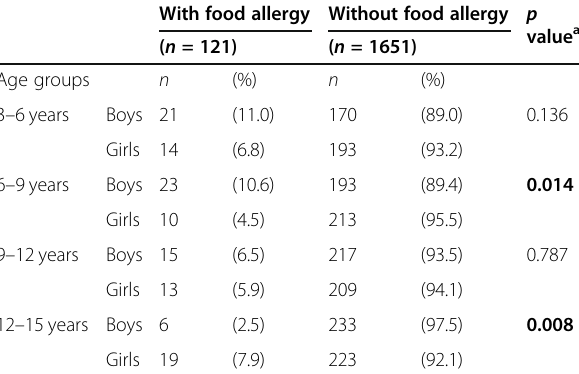
Table 2 The differences in the prevalence of food